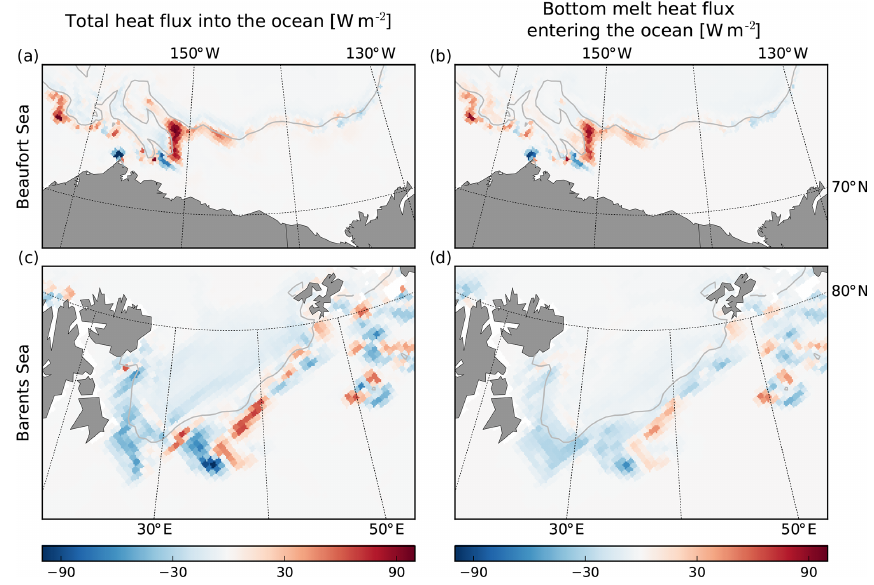
Figure 14. Averaged differences between the CPL and NOT_CPL simulations of (a, c) the heat flux into the ocean and (b, d) the contribution to the heat flux into the ocean coming from the sea ice bottom melt during the storms in the Beaufort Sea (a, b) and in the Barents Sea (c, d) which occurred on 16–17 August 2010. Grey contours indicate the position of the ice edge determined from the averaged sea ice concentration ( c = 0 .